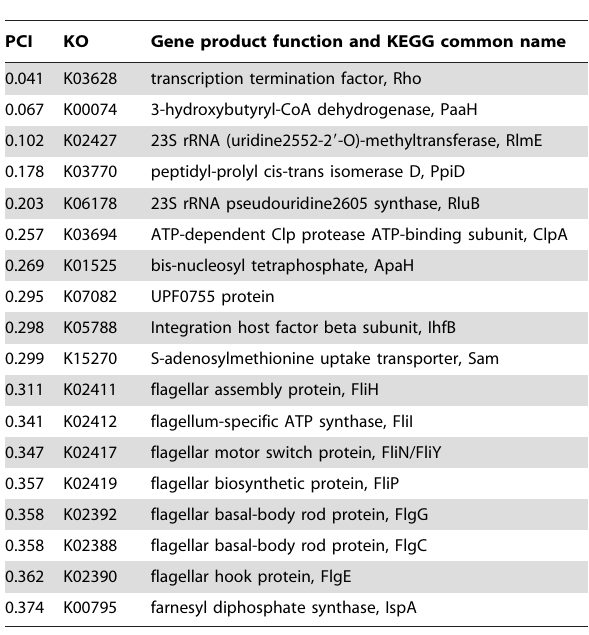
Table 2. Putative Hsp90A clients among 327 hsp90A - associated genes.